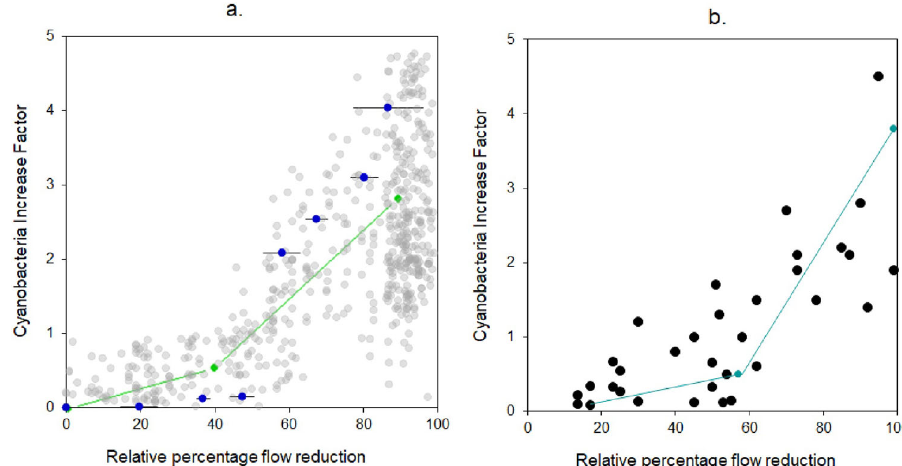
Fig. 4 Benthic cyanobacteria increase factor according to the relative percentage of fl ow reduction. a Measurements (gray circles) of paired cyanobacteria- fl ow monitoring data ( n = 697) at the time of the sample in one location upstream of the water intake and two locations downstream water intakes in seven streams from the water supply system; experimental results (blue circles) of cyanobacteria increase with targeted fl ow reductions including variations ±SE from temporal replicates within fl ow reduction (black lines). Rammer – Douglas – Peucker model (RDP) (green line) fi tted to monitoring data showing a breakpoint for cyanobacteria increase with a 40% fl ow reduction. b A global survey of benthic cyanobacteria- fl ow data ( n = 33) showing a distribution fi tted with RDP model: cyanobacteria increase after a breakpoint of 58% fl ow reduction (teal blue